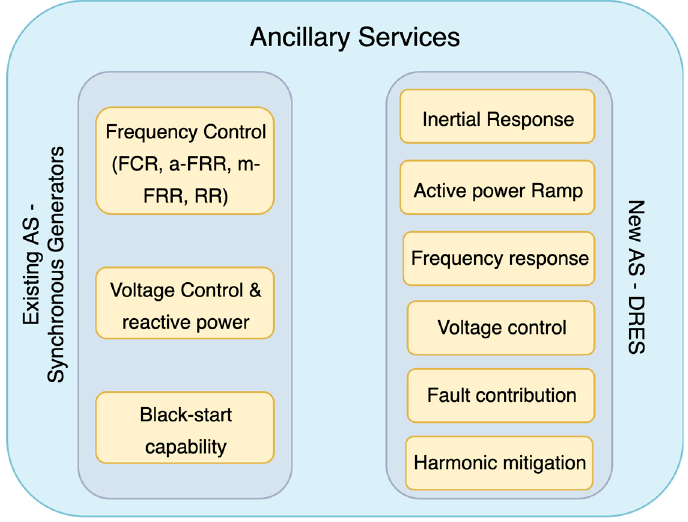
Figure 1. Existing and new ancillary services (ASs) provided by the synchronous generators (SGs) and Distributed Renewable Energy Sources (DRESs), respectively.